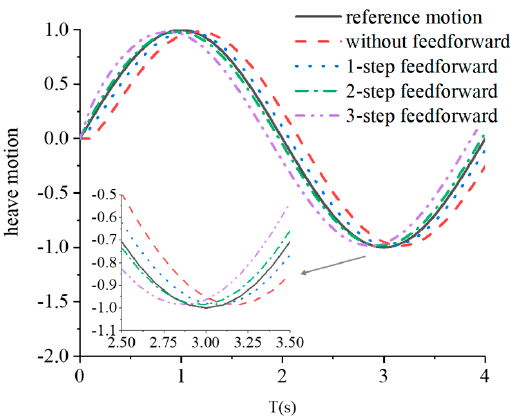
Figure 5. Controller response motions of a sinusoidal signal based on actual-data feedforward control.